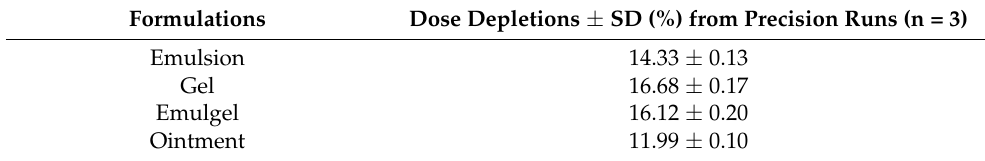
Table 8. Percentage dose depletions for all semi-solid formulations from three IVRT